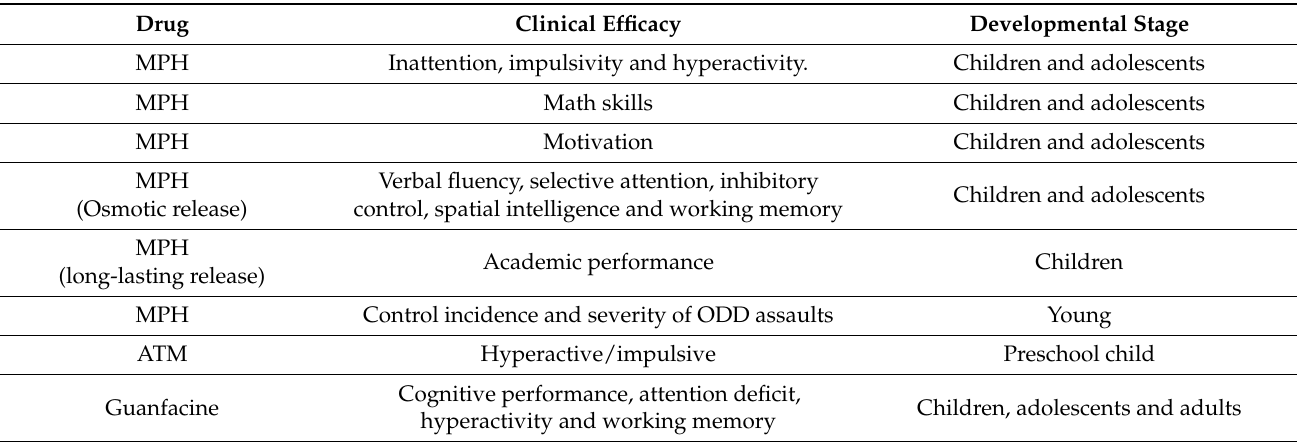
Table 3. Clinical efficacy of the pharmacology therapy for controlling ADHD symptoms throughout